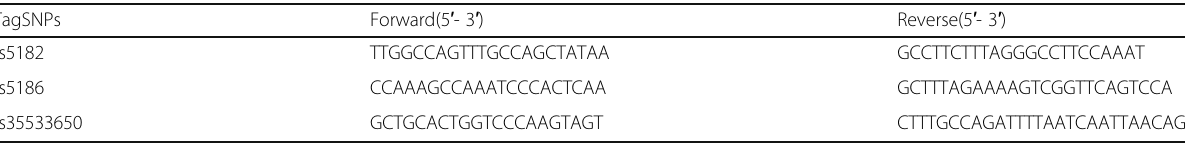
Table 1 PCR primers used in the current study TagSNPs